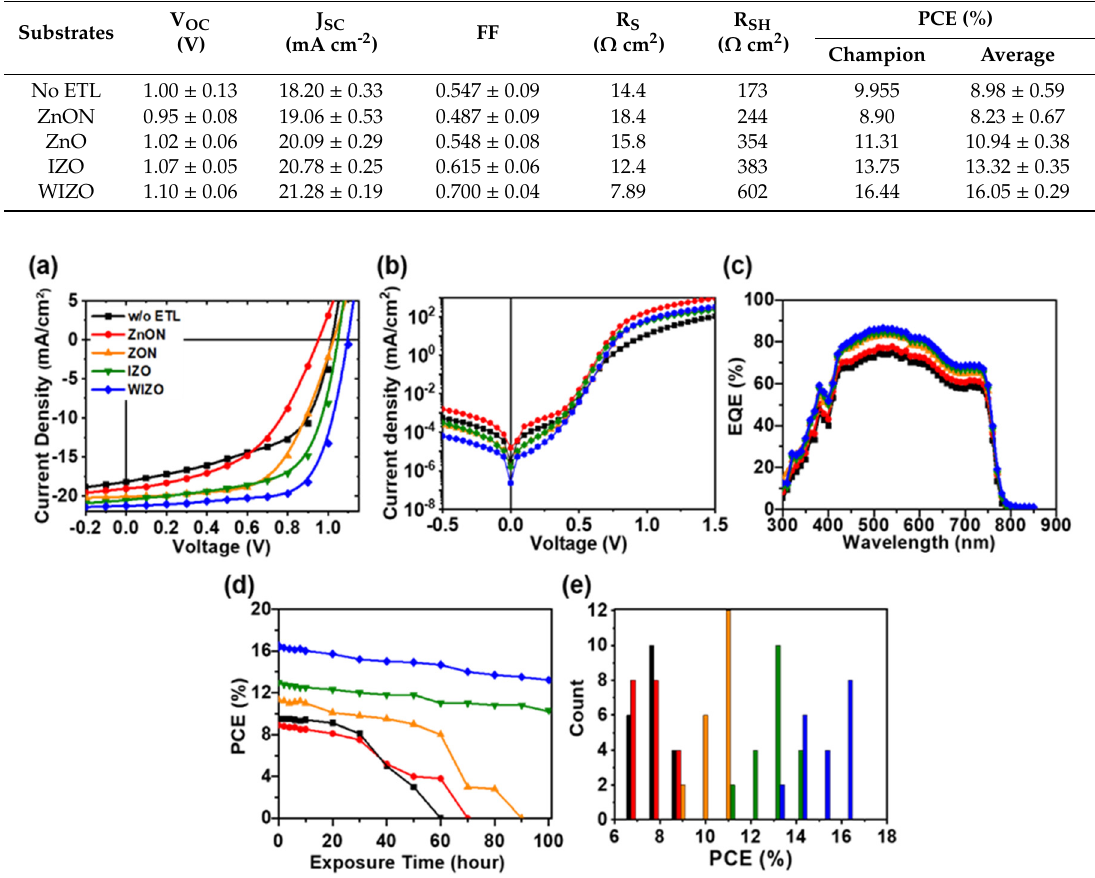
Table 1. Device parameters of the PVSCs based on metal oxide layer .